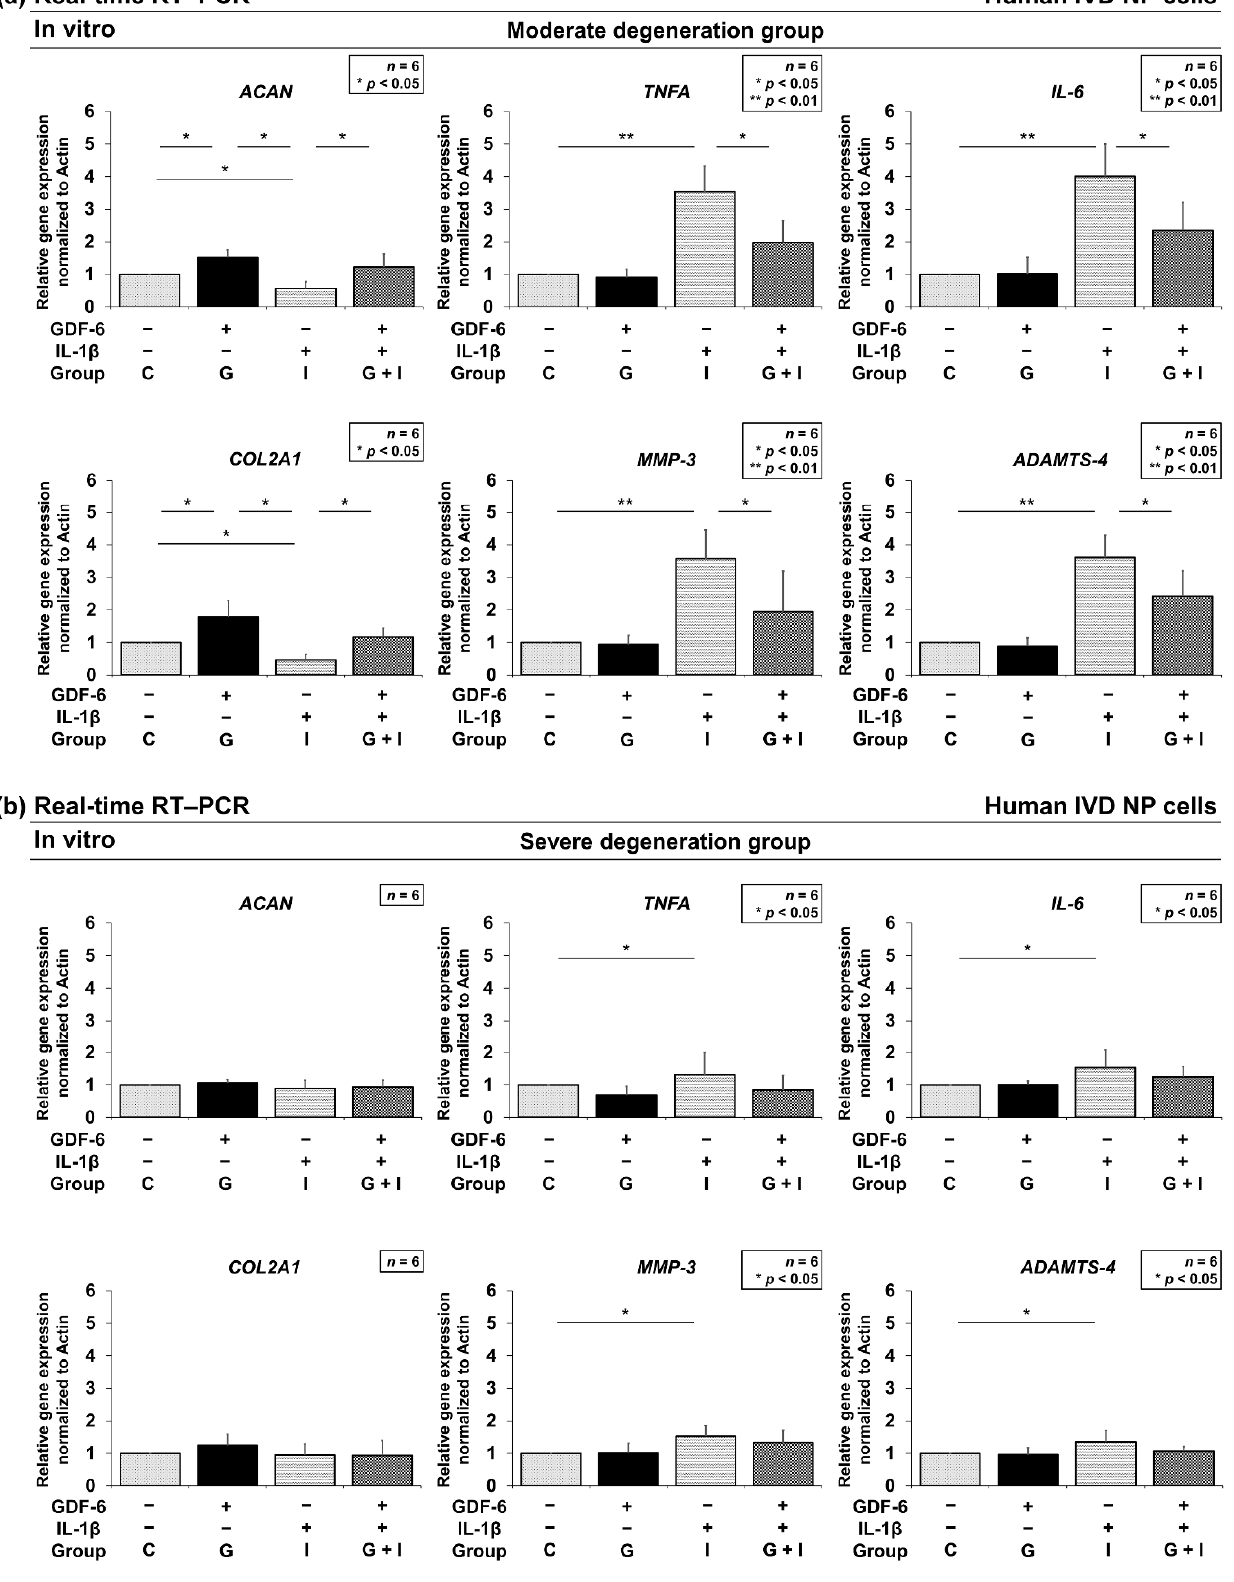
Figure 3. Effects of growth differentiation factor-6 (GDF-6) treatment on anabolic ACAN encoding aggrecan, COL2A1 encoding type II collagen, pro-inflammatory TNFA encoding tumor necrosis factor-α (TNF-α), interleukin ( IL ) -6 , catabolic matrix metalloproteinases-3 ( MMP-3 ), and a disintegrin and metalloproteinase with thrombospondin motifs-4 ( ADAMTS-4 ) gene expression in intervertebral disc